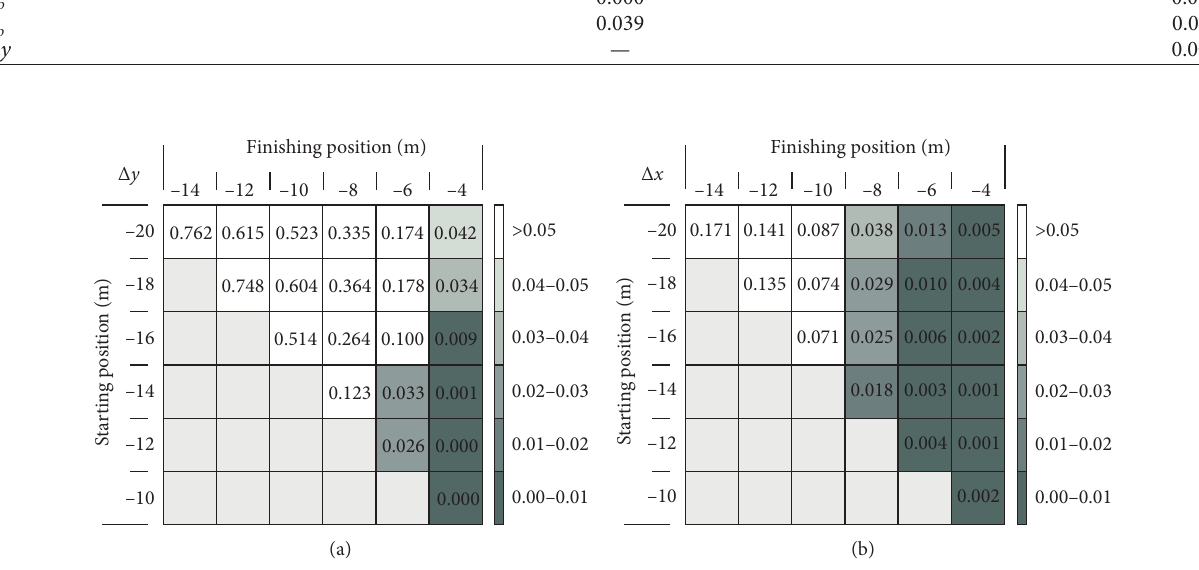
Figure 7: The p value of entrance flow with lateral and longitudinal